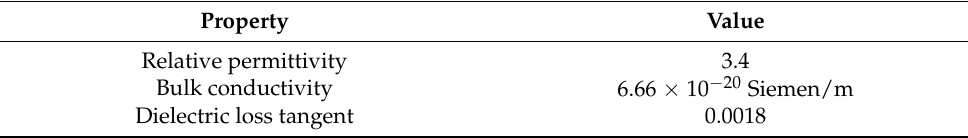
Table 10. Properties of Kapton HN.